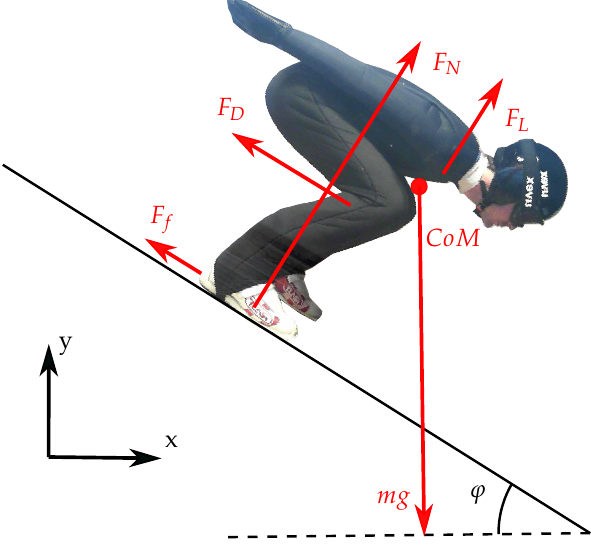
Figure 3. Gravitational ( mg ), normal ( F N ), friction ( F f ), drag ( F D ) and lift ( F L ) forces acting on a ski jumper in an in-run, together with the coordinate system and angle of the hill ( ϕ